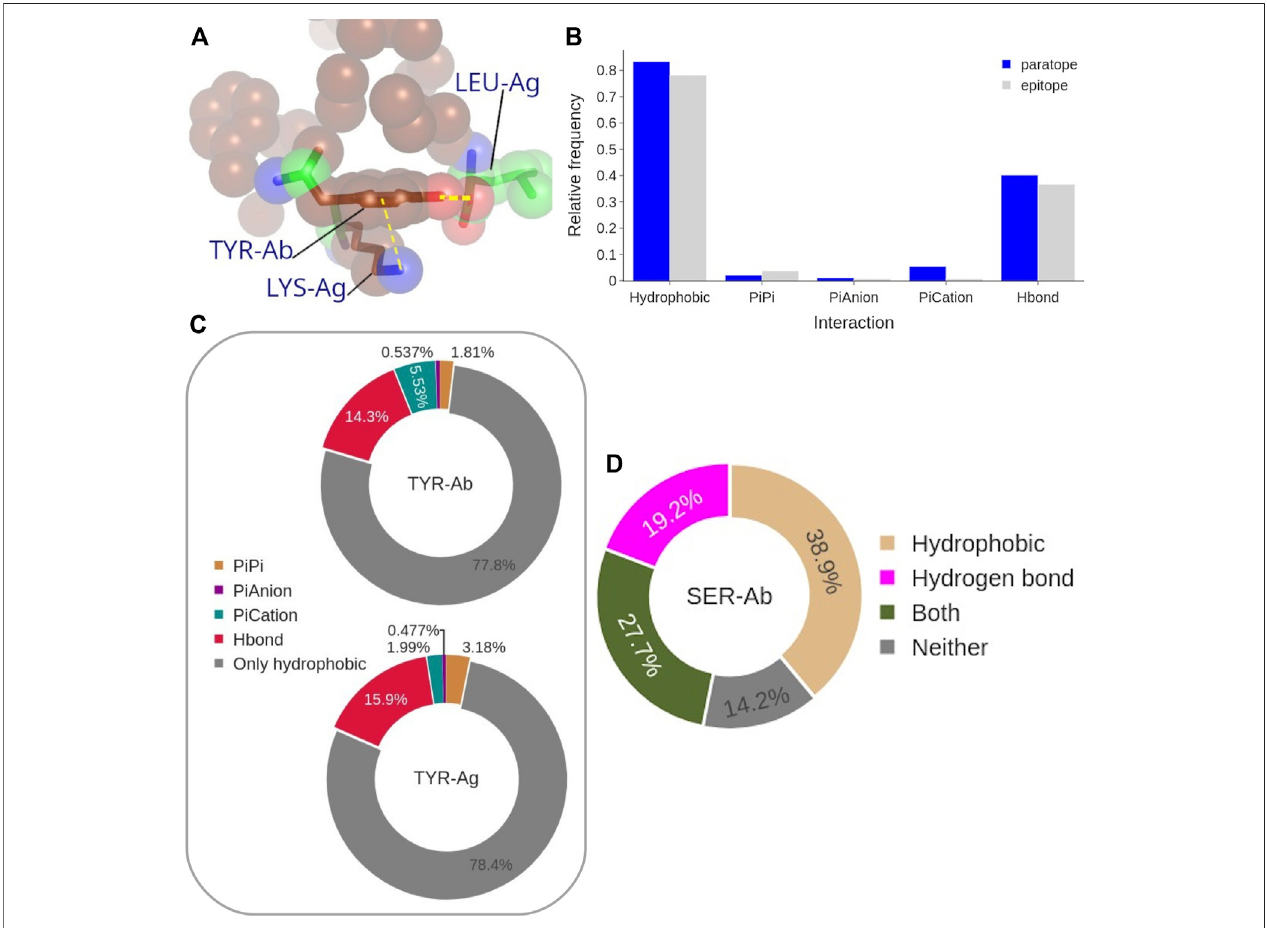
FIGURE 10 | (A) Representative structure of coordinated interactions of Tyr from PDB: 3CVH. Tyr is participating in the main hydrophobic cluster (brown spheres) while forming H-bond and π -cation with two Ag residues. (B) Frequency of each interaction type performed by the paratope (blue) and epitope (gray) Tyrosines. (C) Frequency ofthe coordinated interactions ofparatopeand epitope Tyrosines that occur withinhydrophobicclusters. (D) Frequency of paratope Ser forming H-bond, to participate in a hydrophobic cluster, both, or neither of them.